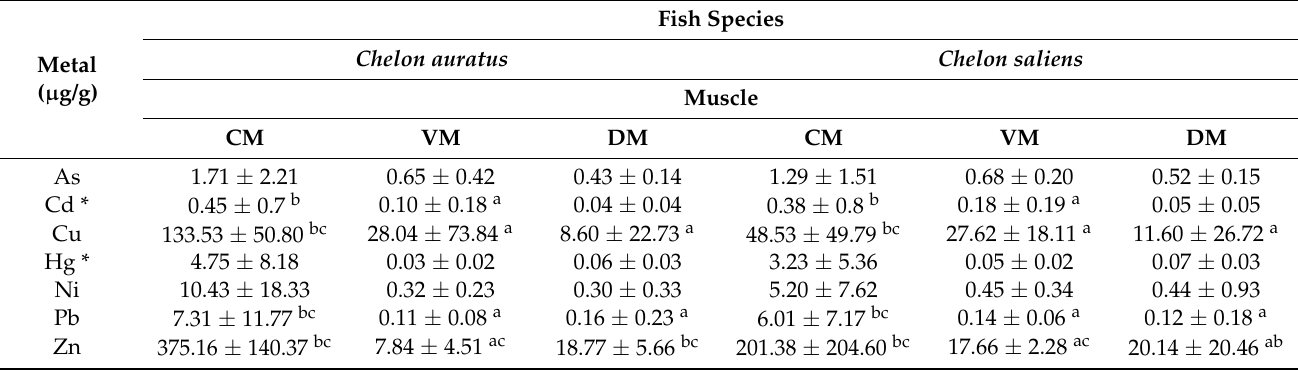
Table 1. Mean values plus minus standard deviations of the metals analyzed in Chelon auratus and Chelon saliens